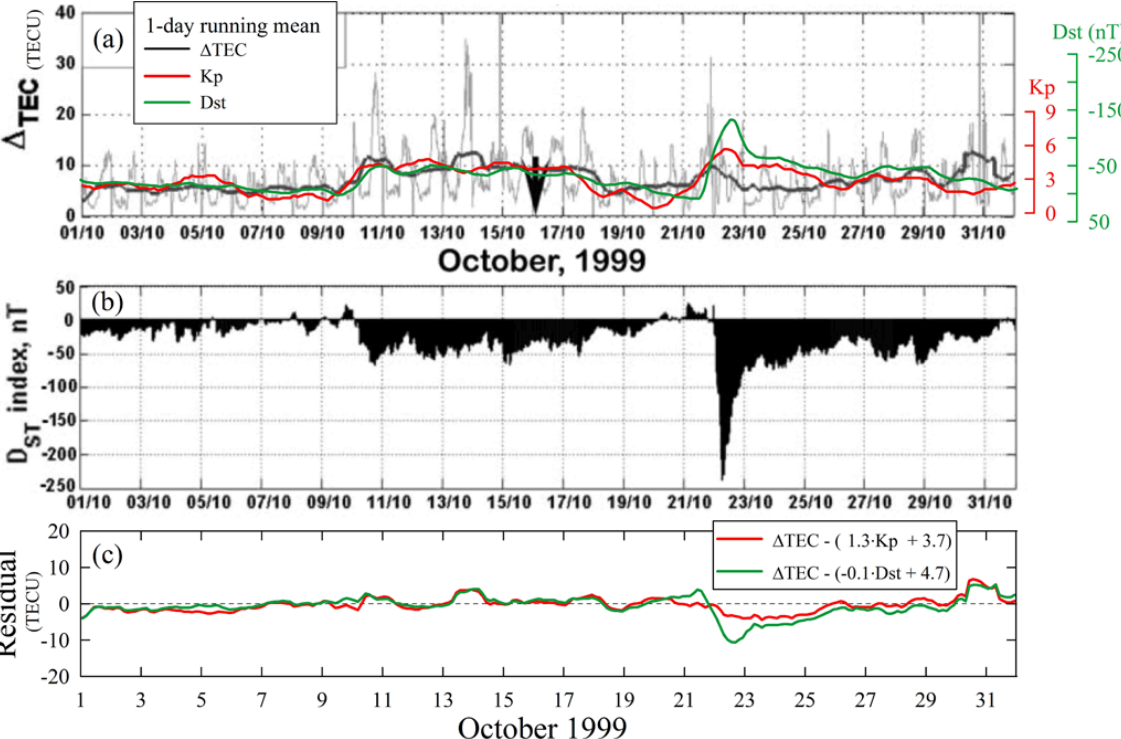
Fig. 1. (a) and (b) : a reproduction of Fig. 6 by Pulinets et al. (2007). Ionospheric regional variability index 1 TEC (a) and Dst geomagnetic index (b) during October 1999. The black arrow indicates the date of the Hector Mine earthquake. Geomagnetic Kp and Dst indices time series are superimposed onto panel (a) . (c) Residual time series of the linear relationship between the 1-day running average of the geomagnetic indices and that of 1 TEC. The TEC units are TECU, where 1 TECU = 10 16 electronsm − 2 . See text for